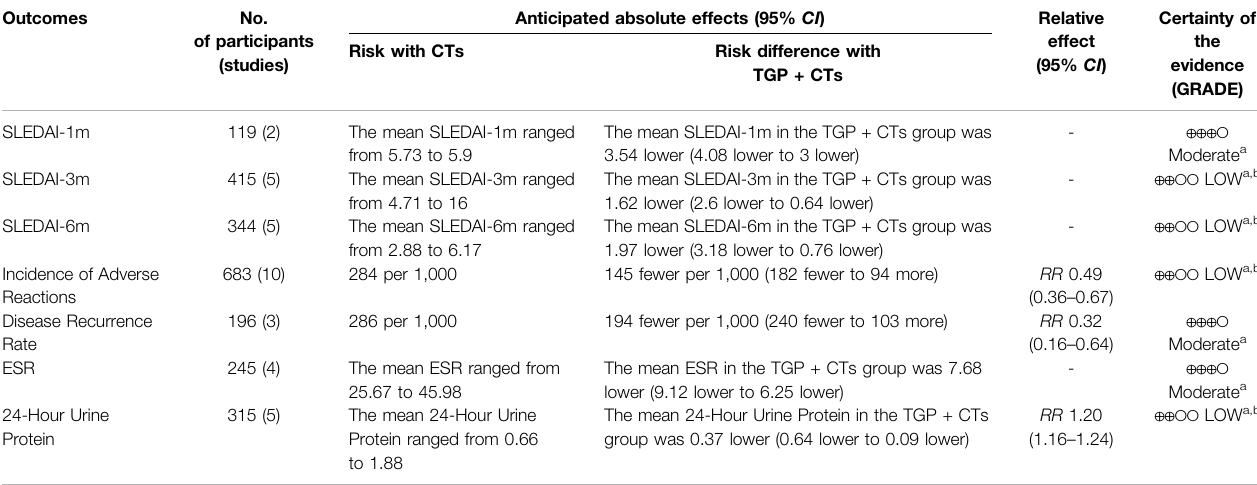
TABLE 2 | GRADE summary of outcomes for TGP + CTs versus CTs for patients with SLE.